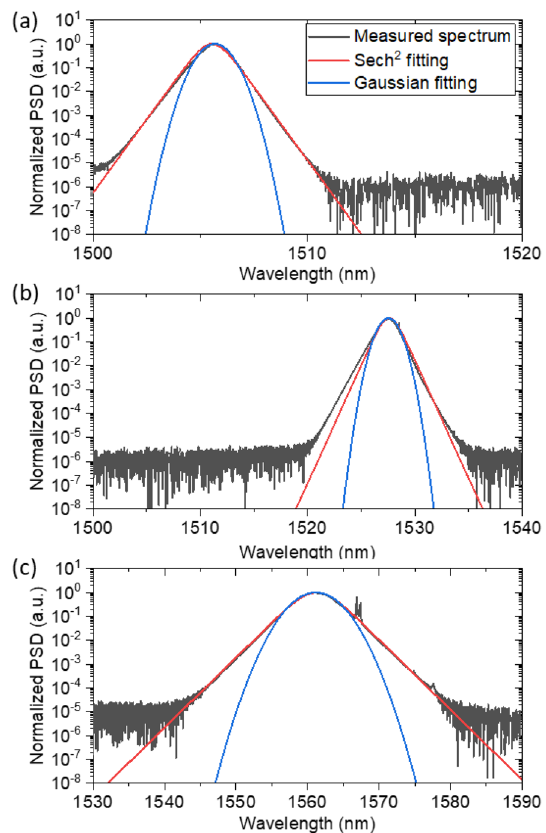
Figure 5. | Curve fittings of some examples of the optical spectrum to Gaussian and Sech 2 curves: Curve fitting results for the center wavelengths of ( a ) 1505 nm, ( b ) 1527 nm, and ( c ) 1561 nm.